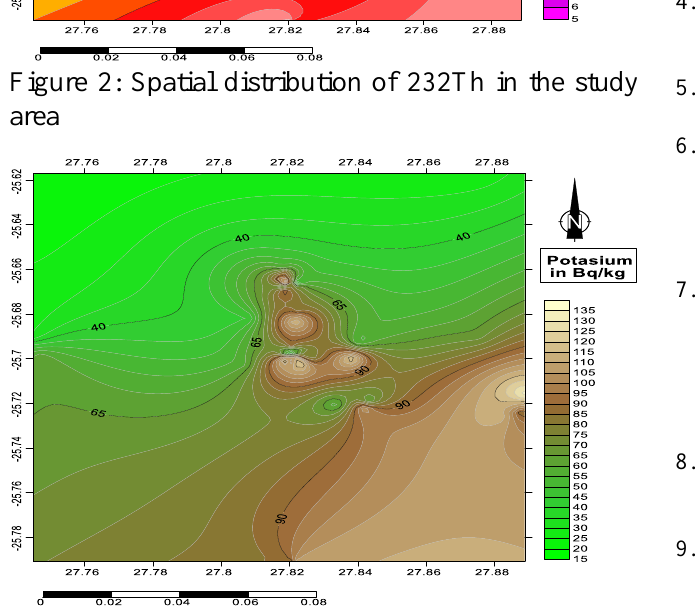
Figure 3: Spatial distribution of 40 K in the study